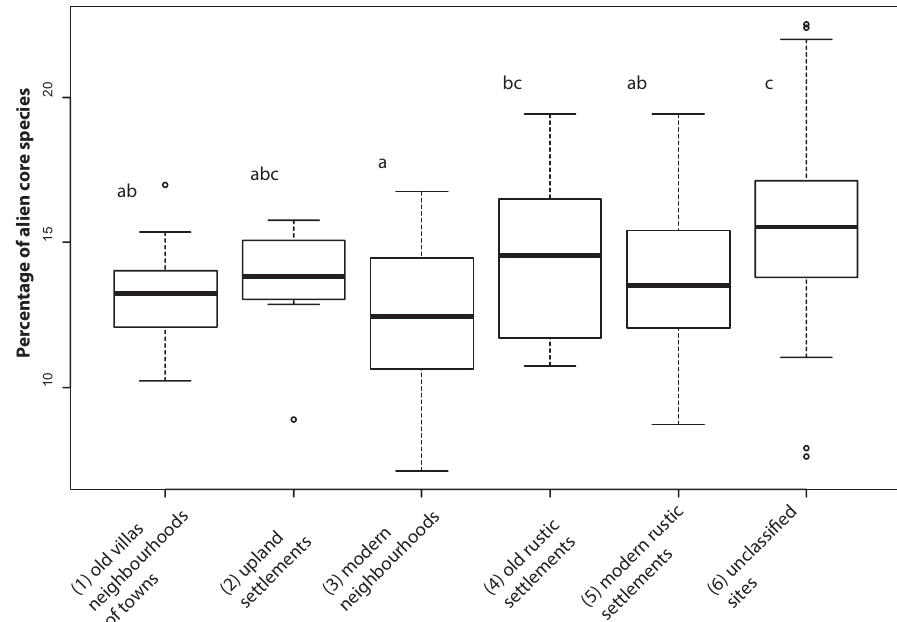
Figure 3. Differences in the percentages (i.e. median, 25 th and 75 th percentile and min/max values) of core alien ornamental taxa (i.e. frost-resistant cultivated plants that persisted for a long time after aban- donment or taxa that occur at many sites) within clusters of classified settlement types and within the un- classified cluster. Same letters above the boxes indicate insignificant differences between clusters (ANOVA F = 5.69, df (5, 168), p <